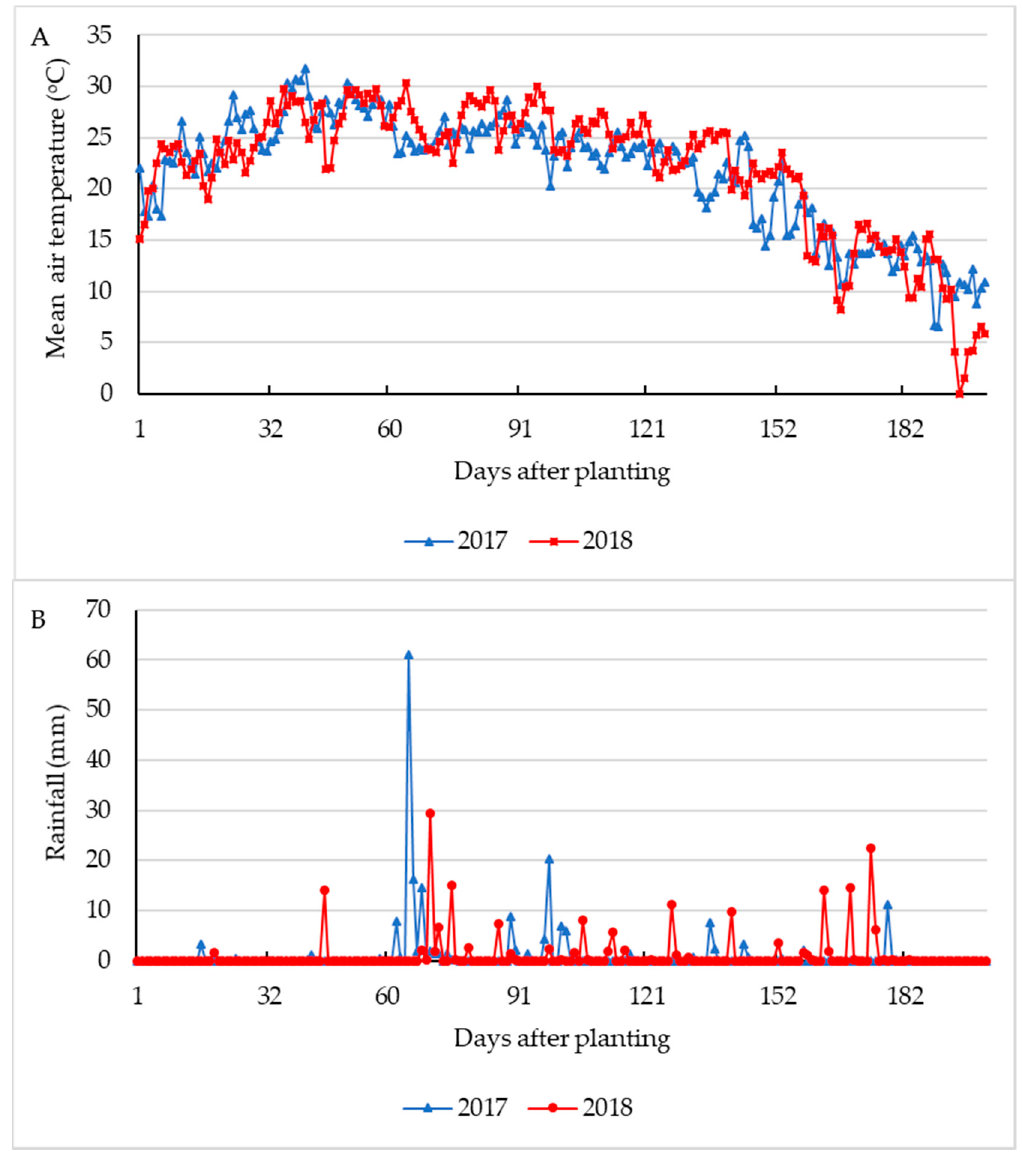
Figure 1. Mean air temperature ( A ) and rainfall ( B ) during the growing season at the trial site in 2017 and 2018.